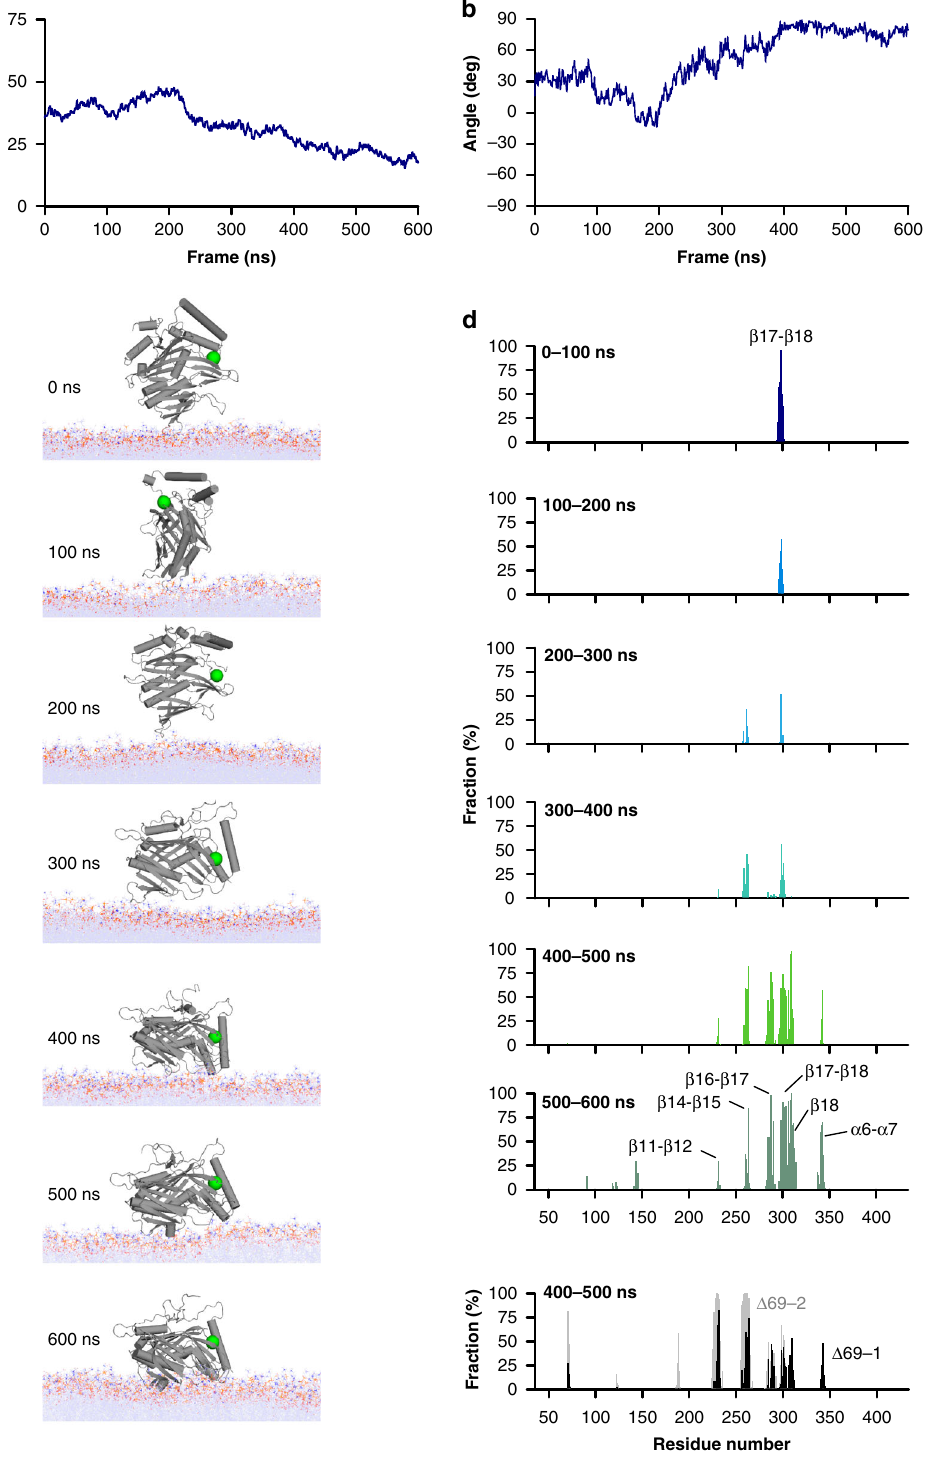
Fig. 7 Removal of the lid elicits the reorientation of Osh6p on a bilayer surface. a Evolution of the height between the center of mass of the protein relative to the plane of the bilayer during 600ns. b Evolution of the angle between the α 7-helix and the plane of the membrane during the trajectory. c Snapshot at time zero and every 100 ns of the trajectory showing the reorientation of the protein relative to the lipid bilayer. d Percentage of time Osh6p ’ s residues (f values) are in contact with membrane during six successive periods (100 ns each) of the trajectory. The loops corresponding to residues in contact with membrane are indicated. As a comparison, the f values are indicated for the last 100 ns of the Δ 69-1 and Δ 69-2 trajectories, during which Osh6p Δ 69 is membrane-bound. The f values of the last 100 ns of the Δ 69-3 trajectory, similar to those of the Δ 69-2 trajectory, were omitted for clarity. Source data are provided as a Source Data fi